Question: Which visualization type does this figure use?
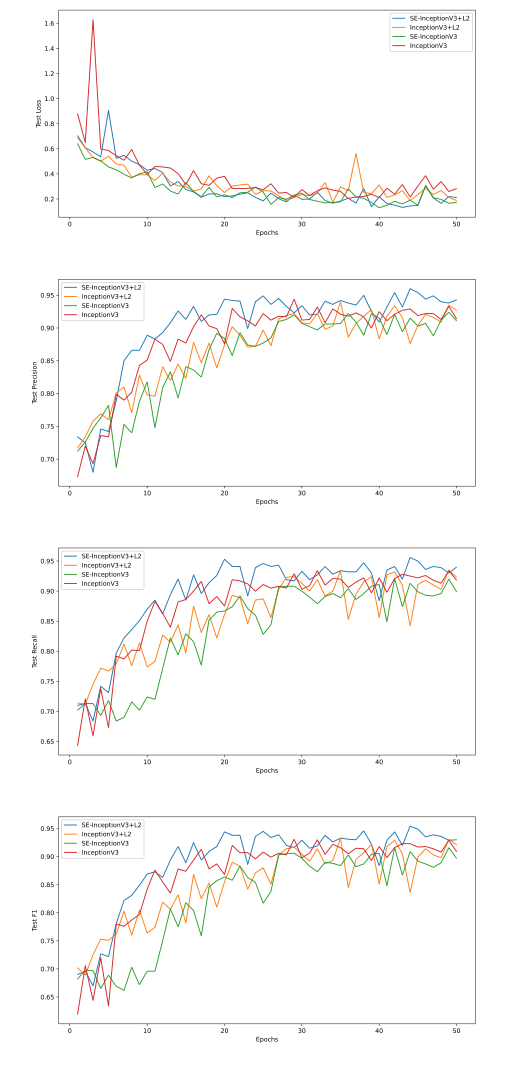
Answer: line